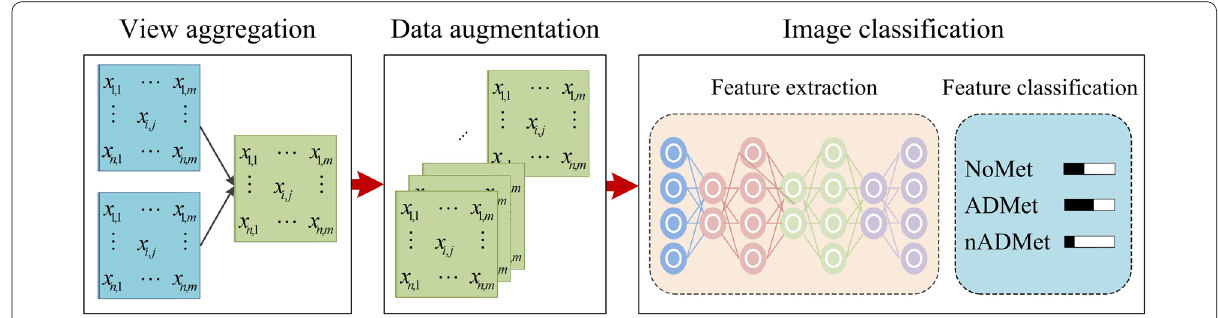
Fig. 1 Overview of the proposed CNN-based multiclass classification method